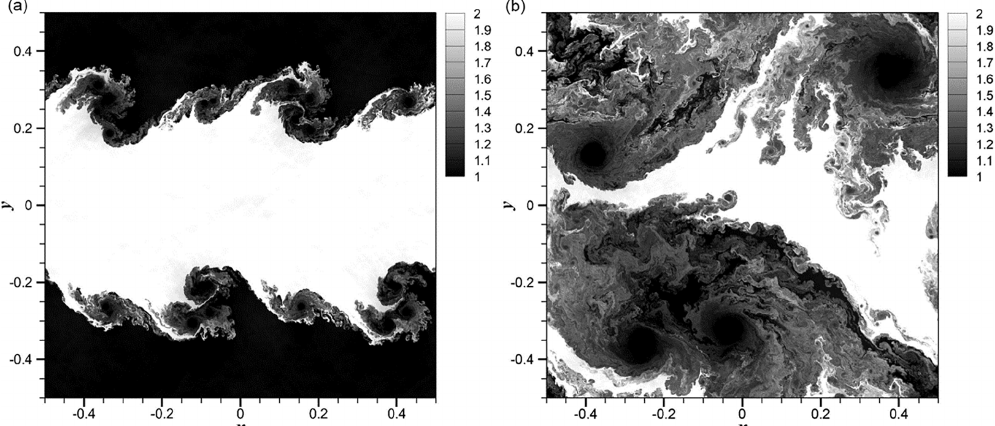
Figure 3. Time evolution of the density field for 2-D KHI turbulence with α = 0 . 5 demonstrating results at t = 1 (a) and t = 5 (b) obtained by a grid resolution of N 2 = 16384 2